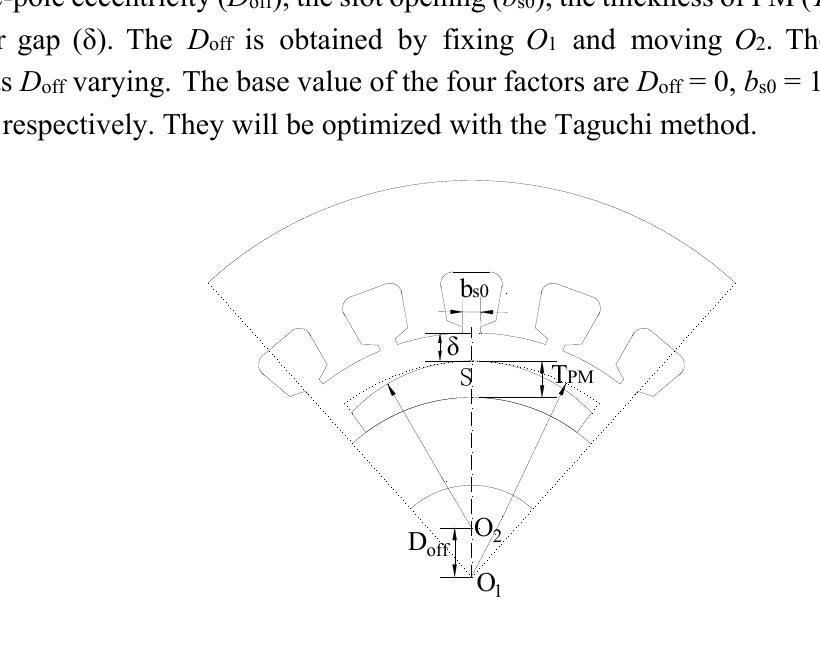
Figure 8. Four parameters to be optimized: D off , b s0 , T PM , δ